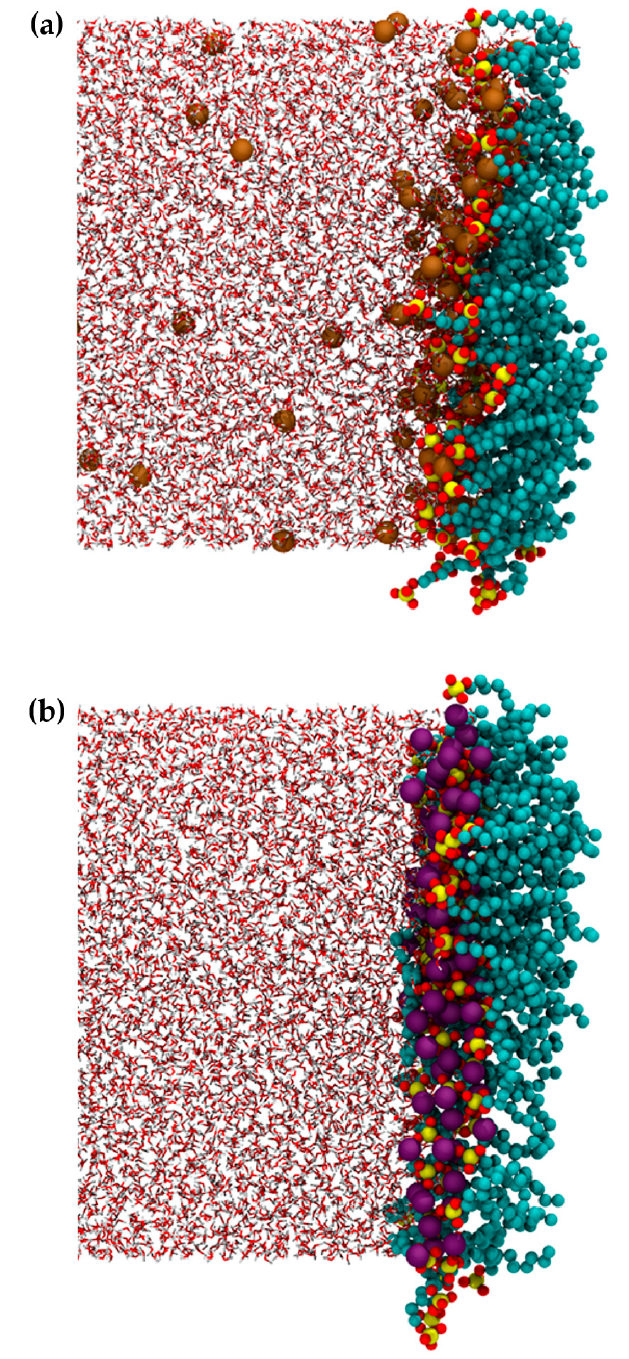
Figure 1. Equilibrium snapshot of the surface portion of the systems consisting of ( a ) Na + and ( b ) Cs + counterions, as taken from our simulations. The Na + and Cs + ions as well as the C, S, O, and H atoms are marked by brown, purple, blue, yellow, red, and white colors, respectively. Water molecules are represented by sticks, while H atoms of the DS − ions are omitted from the snapshots for clarity.